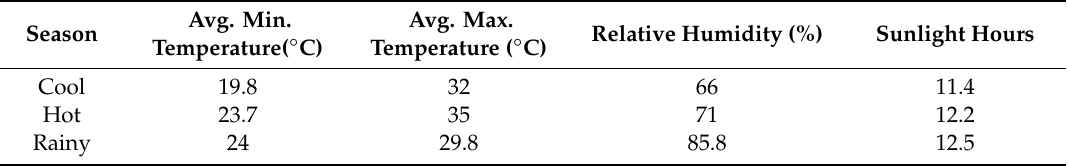
Table 3. Climate conditions in Yangon